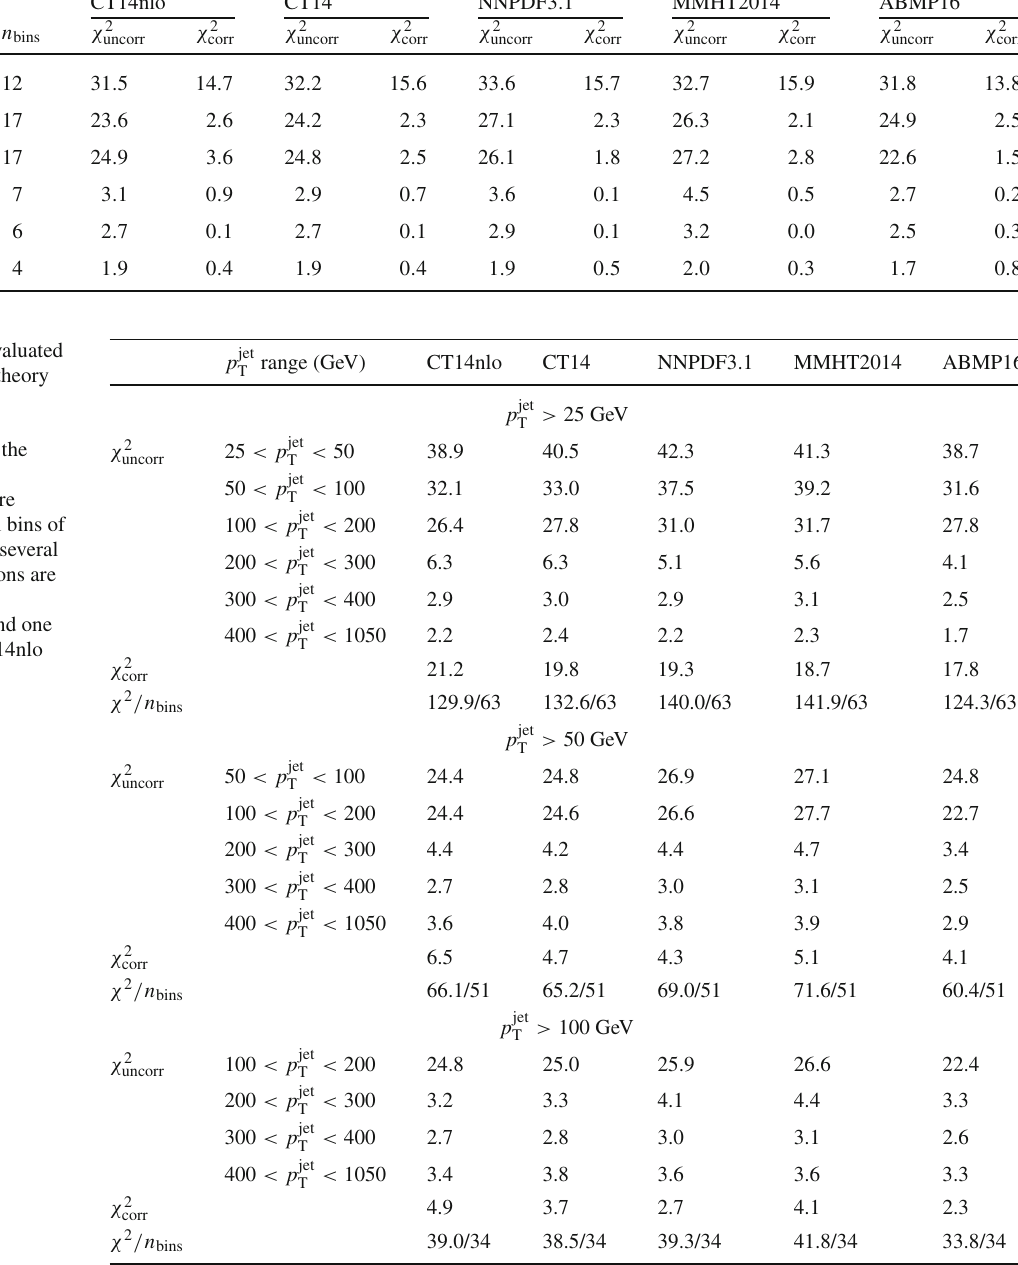
Table 1 Values of χ 2 uncorr and χ 2 corr evaluated for theory predictions corrected for non-perturbative and electroweak effects and measured Z + jets cross-sections. The total χ 2 is equal to the sum of χ 2 uncorr and